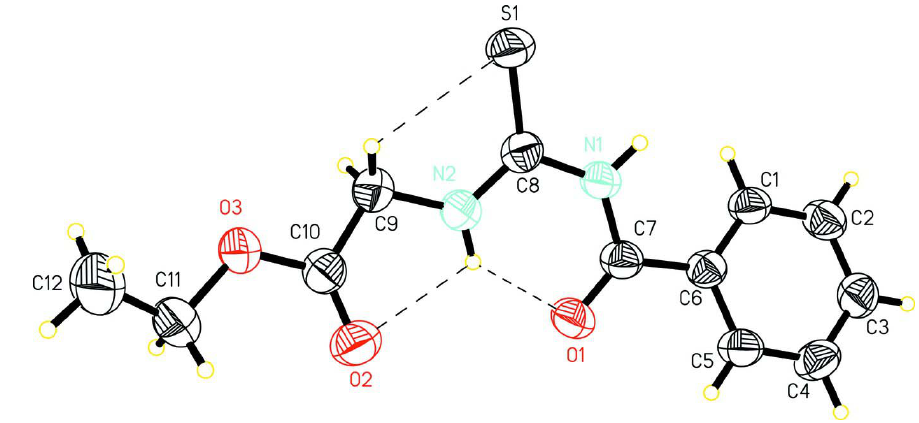
Figure 1 The molecular structure of (I), with displacement ellipsods drawn at the 50% probability level.